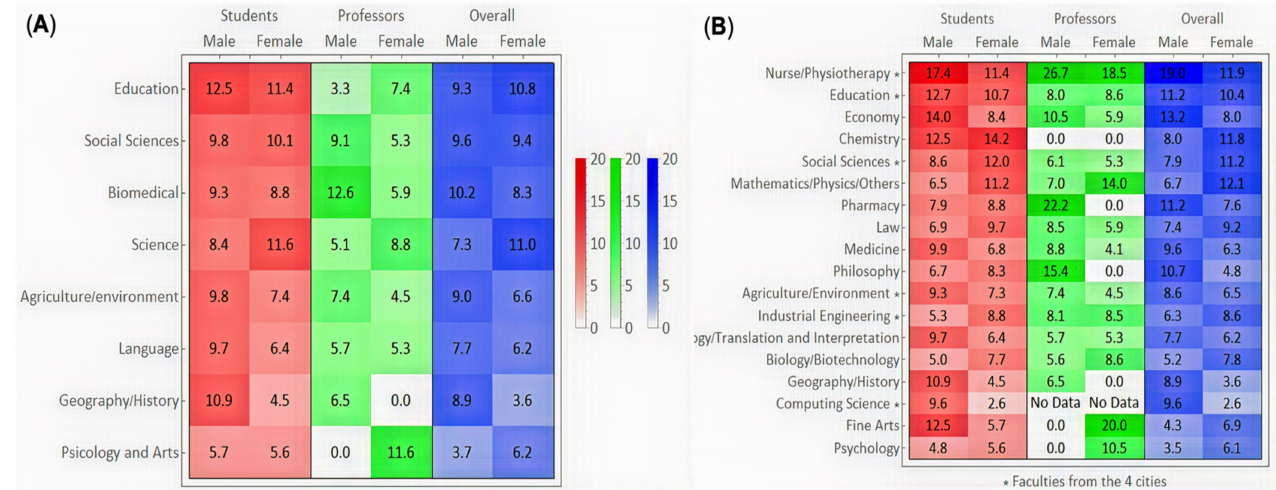
Figure 3. Seroprevalence in University of Salamanca Campus: ( A ) Faculties in Salamanca city, ( B ) distribution according sex and